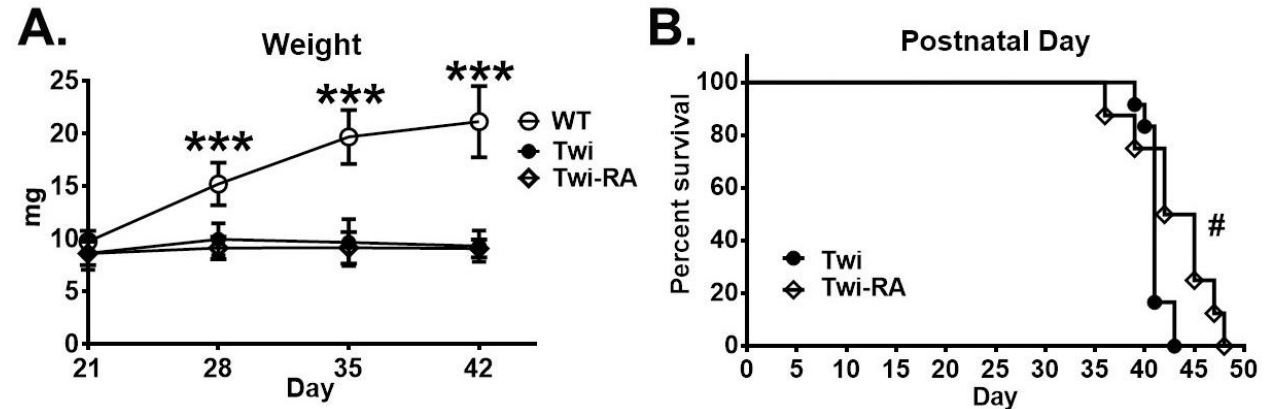
Figure 8. Rapamycin prolonged lifespan in twitcher mice. ( A ) Body weight of wild-type (WT; n = 12) mice, untreated twitcher (Twi; n = 12), and rapamycin-treated twitcher (Twi-RA; n = 8) mice was measured every 7 days commencing at 21 days of age. Values are expressed as mean ± SD and compared using One way ANOVA (Tukey post hoc test). Statistical significance, *** p < 0.001 (comparing to WT). ( B ) Kaplan–Meier curve showing increased lifespan in rapamycin-treated (Twi- RA; n = 8) mice compared to untreated twitcher (Twi; n = 12) mice. # p < 0.05 (Twi-RA versus Twi using Student’s t test).